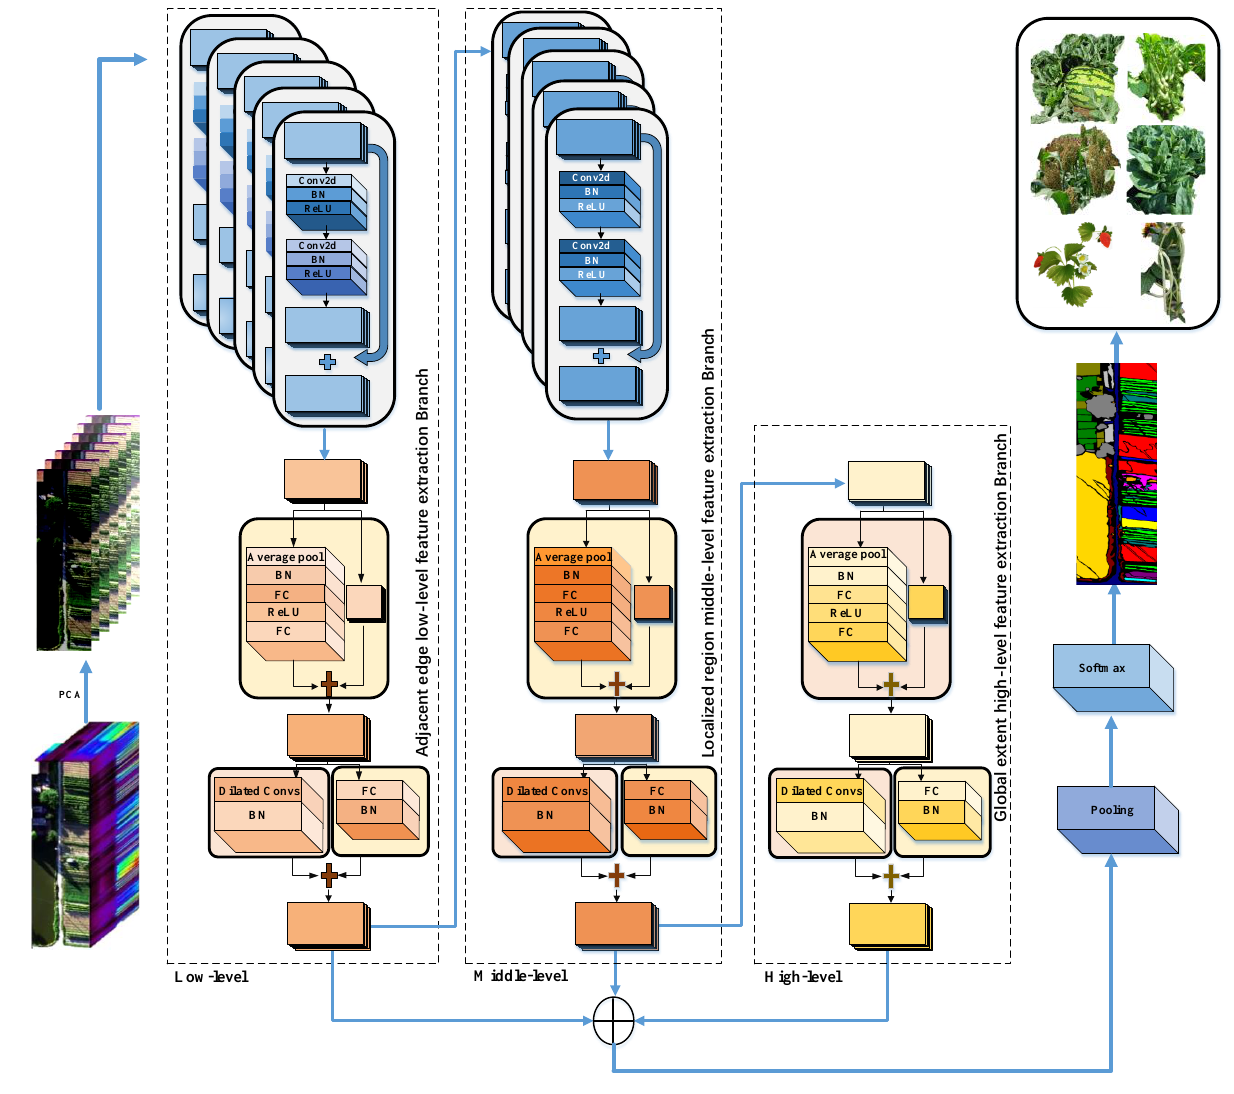
Figure 1. Framework of the proposed DMLPFFN for HSI